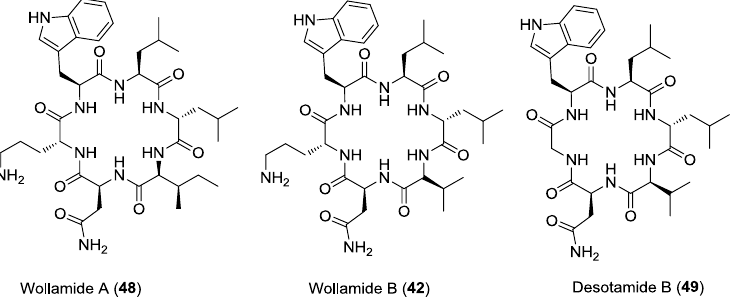
Figure 9. Wollamides A ( 48 ), and B ( 42 ) and desotamide B ( 49 ).